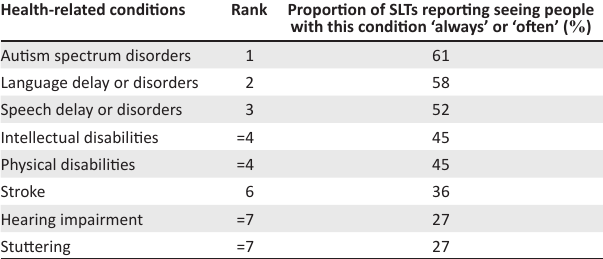
TABLE 5: Most frequently reported health-related conditions of people accessing speech and language therapy services. Health-related